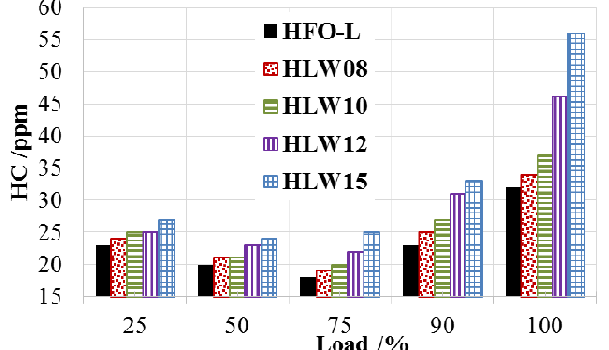
Figure 17. Variation tendency of HC.